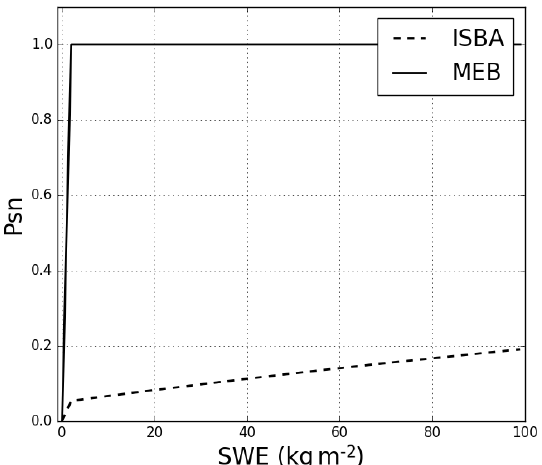
Figure 2. Snow fraction for different values of SWE for ISBA and MEB over a forest of 11m height and assuming a density of 200kgm − 3